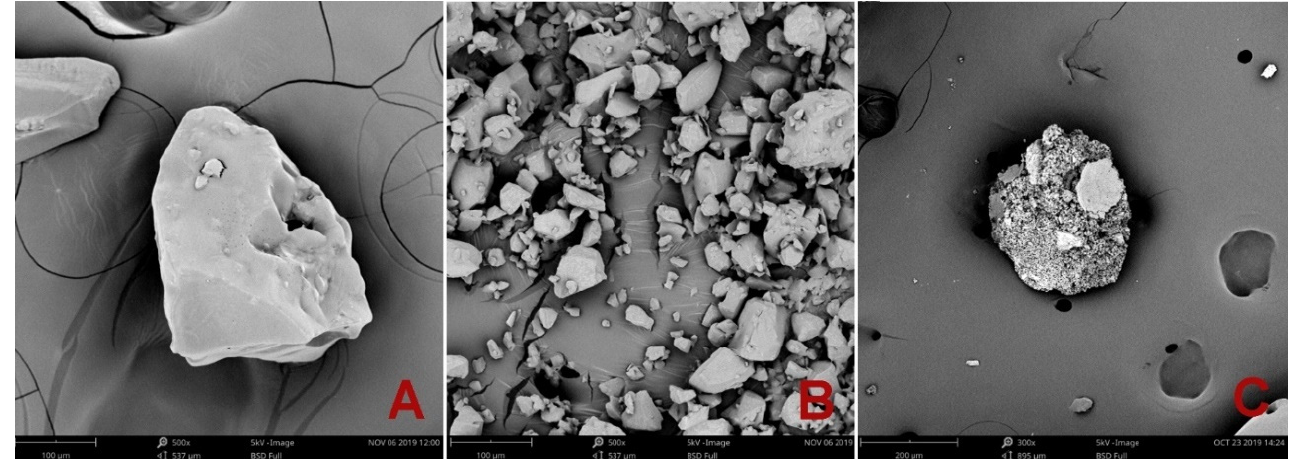
Figure 2. SEM images of ( A )—Creasorb SIS; ( B )—Cabloc CT; ( C )—Hydropam.